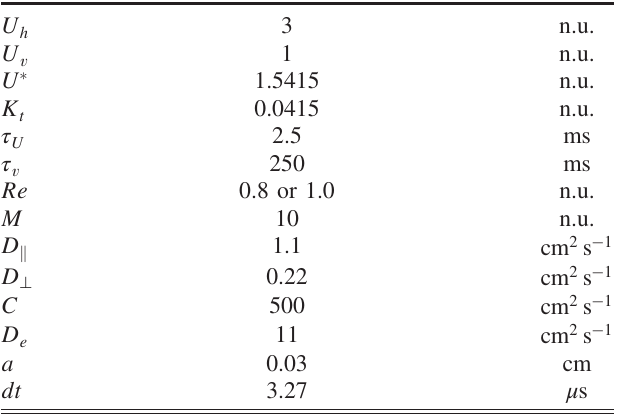
TABLE I. Parameters for the electrophysiology and MSM models. n.u. stands for no